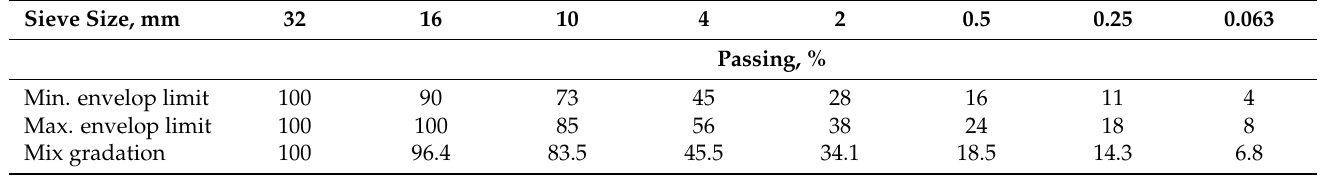
Table 4. The mix gradation and Italian specification limits for an AC binder